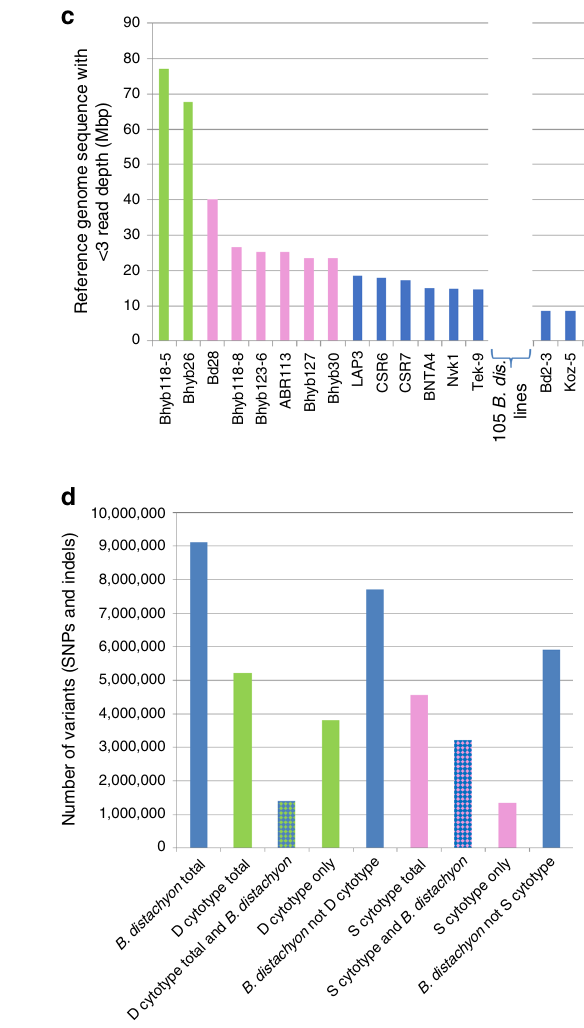
Fig. 8 Reference-based analysis. Individual Illumina sequence reads, or simulated reads created by shredding a PacBio assembly (Bd28 accession), were mapped to the B. distachyon Bd21 reference genome to identify SNVs ( a ), small indels ( b ), and larger missing or highly divergent regions ( c ). In each graph, the lines have been ordered by descending number of polymorphisms, showing a trend from high levels in the B. hybridum D-plastotype lines, moderate levels in the B. hybridum- S-plastotype lines, and low levels in the B. distachyon lines. For clarity, 105 intermediate B. distachyon lines were omitted from the graphs. The B. hybridum D and S-plastotype lines both have signi fi cantly more SNVs, indels and deleted or highly divergent regions than B. distachyon ( t tests, P < 10 − 20 ), whereas the B. hybridum D-plastotype lines had signi fi cantly more SNVs, indels ( t test, P < 10 − 9 ) and deletions or highly divergent regions ( t test, P < 10 − 4 ) than the S-plastotype lines. Note that the amount of deletion/highly divergent regions in Bd28 may be in fl ated by using a PacBio assembly that has more repetitive sequence assigned to the D subgenome than is possible by mapping Illumina reads. d The number of variants shared and unique to different groups. Green bars correspond to B. hybridum D plastotype, pink bars to B. hybridum- S plastotypes, and blue bars to B. distachyon accessions. Source data are provided as a Source Data fi